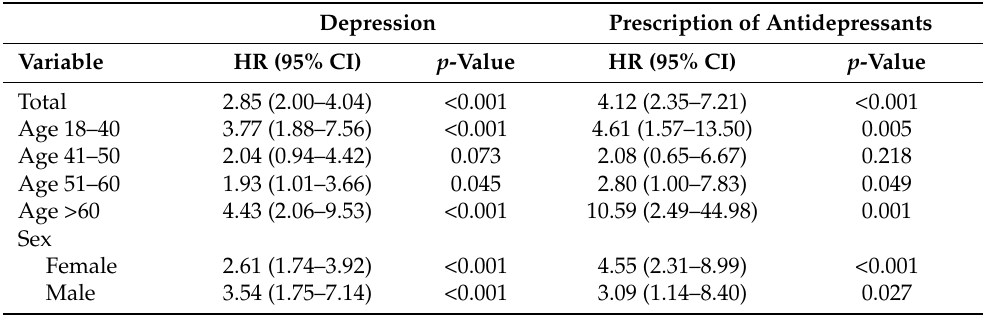
Table 2. Association between dysbiosis and the incidences of depression and antidepressant therapy in patients followed in general practices in Germany (Cox regression